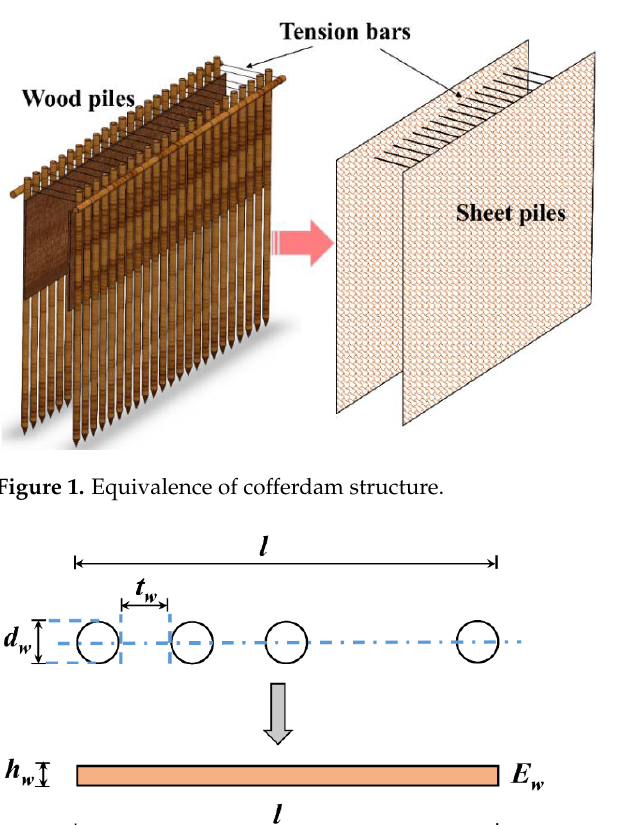
Figure 2. Equivalent of wood piles.